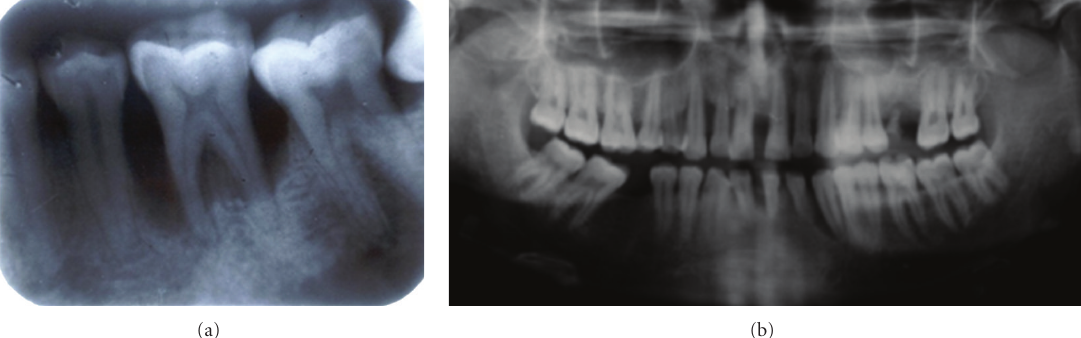
Figure 4: (a) Arc-shaped radiolucency at the 1st molar region in localized aggressive periodontitis. (b) Generalized distribution of bone loss seen in GAgP with vertical